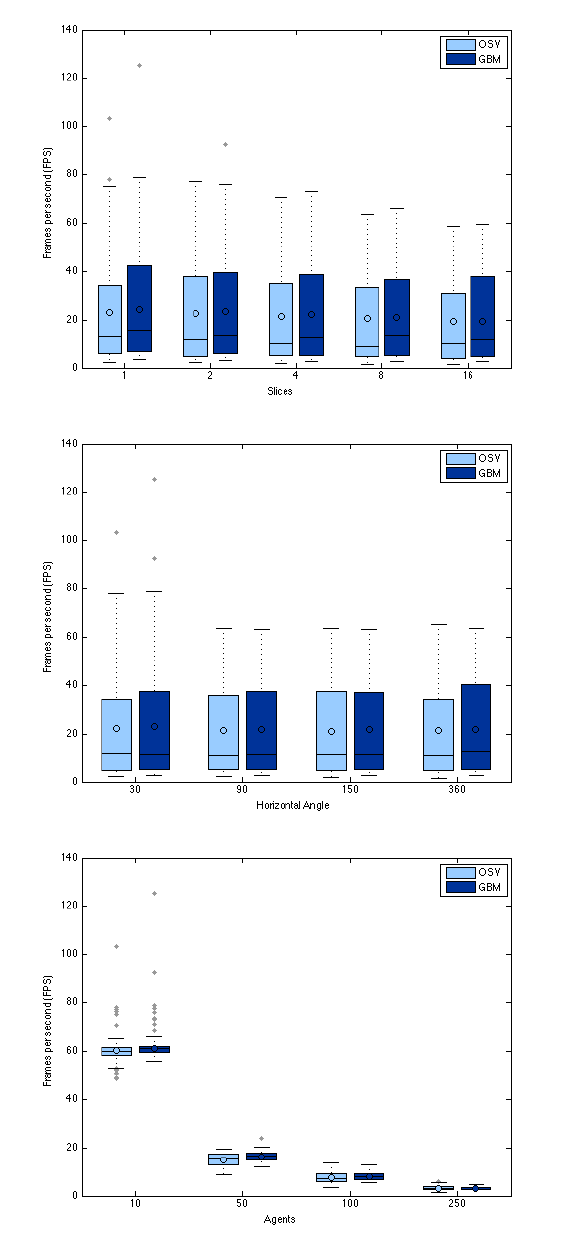
Figure 11. Results for the performance test. The graphics show the influence of the number of slices of the vision (top), the horizontal angle (middle) and the number of agents (bottom) on the FPS for each model.